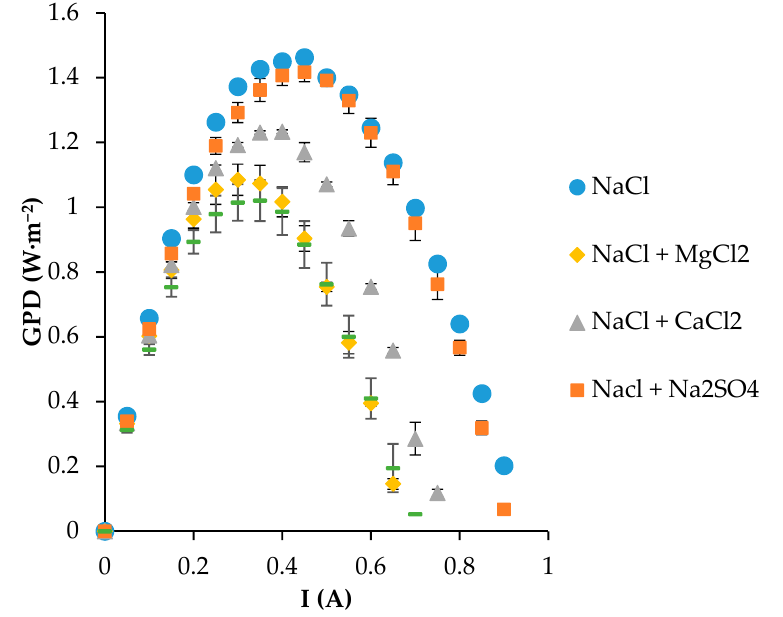
Figure 7. Gross power density achieved with NaCl and divalent ions.